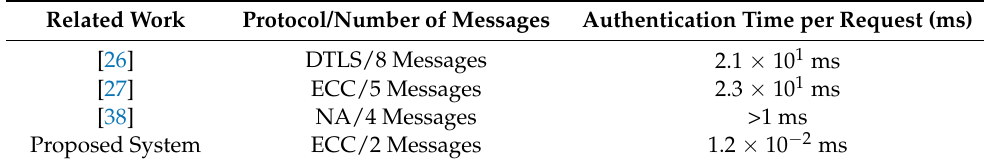
Table 4. Comparison of the results with related works based on the authentication time.